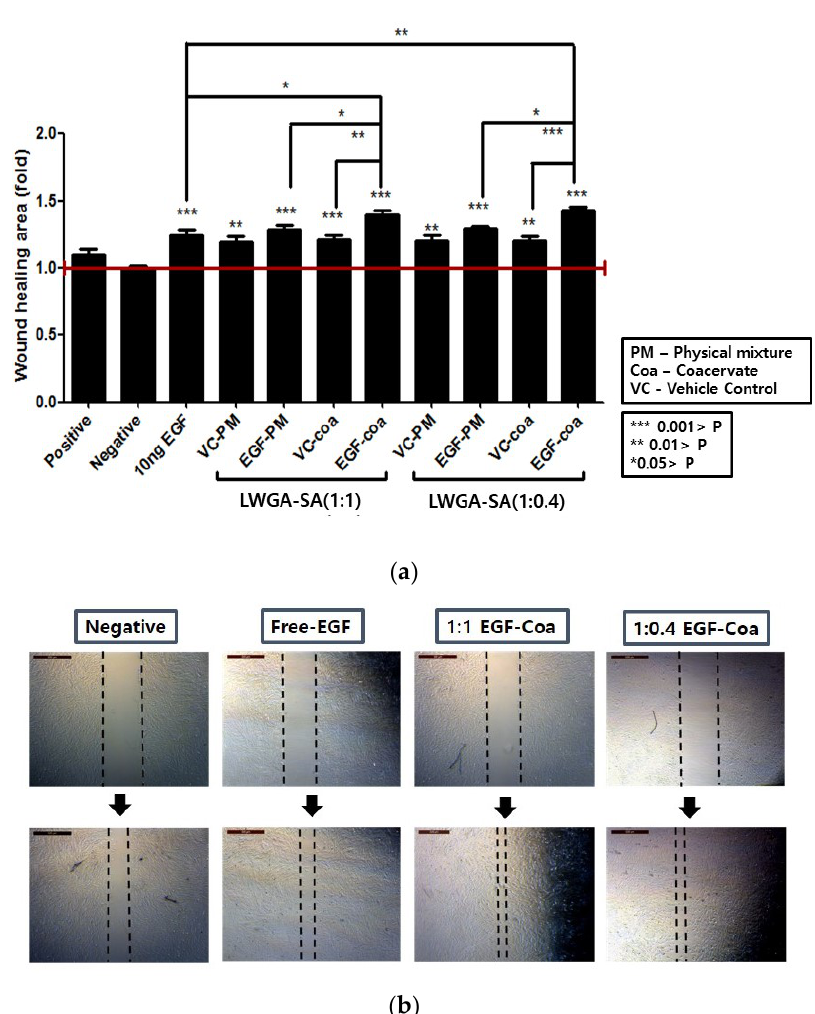
Figure 6. Human dermal fibroblast scratch wound assay. Positive control: 10% fetal bovine serum (FBS); Negative control: 0.5% FBS; Free-EGF (10 ng/mL solution); Freeze-dried samples (VC-PM) EGF-PM, VC-Coa, EGF-Coa). For each ratio of LWGA-SA, VC-PM stands for freeze dried samples of LWGA and SA solution, EGF-PM for freeze dried sample of LWGA, SA, and EGF in solution, VC-Coa for freeze dried sample without EGF, and EGF-Coa for freeze dried sample of LWGA-SA coacervates encapsulating EGF. ( a ) Quantitative wound healing rate by microscopic images analysis using Image-Pro Plus software, followed by one way ANOVA with GraphPad Prism software for statistical analysis. ( b ) Representative microscopic images of scratch wounds on confluent HDFs monolayers after treatment with media alone, free EGF solution, EGF-Coa with LWGA-SA (1:1), and EGF-Coa with LWGA-SA (1:0.4): Upper panels at time 0 and lower panels at 8 h time point of incubation.